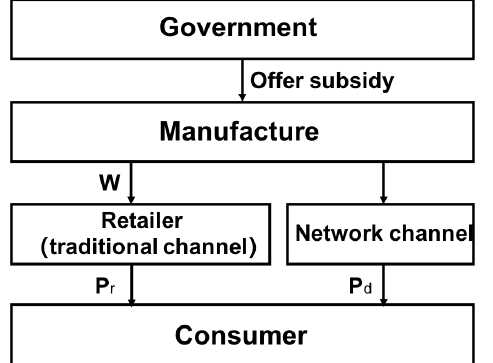
Figure 1. The structure of the dual-channel green supply chain.